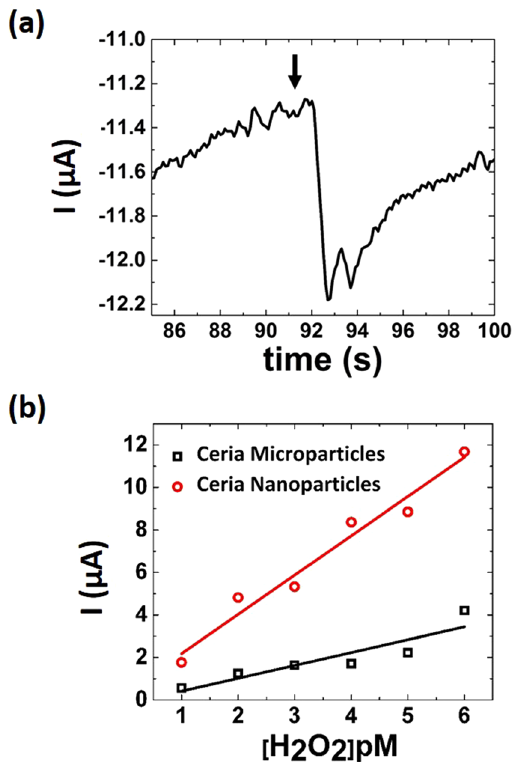
Figure 4. ( a ) Picomolar detection by biosensor. Addition of H 2 O 2 to a final concentration of 1 pM produces a 350 nA signal, compared with the nanomolar limit of detection of most enzymes. (b) Nano v. Micro particle characterization. CNPs show significantly greater sensitivity towards H 2 O 2 analyte as compared to ceria microparticles-based sensor; this greater signal is attributed to nano-size effects and specifically to the change in nanomaterial surface